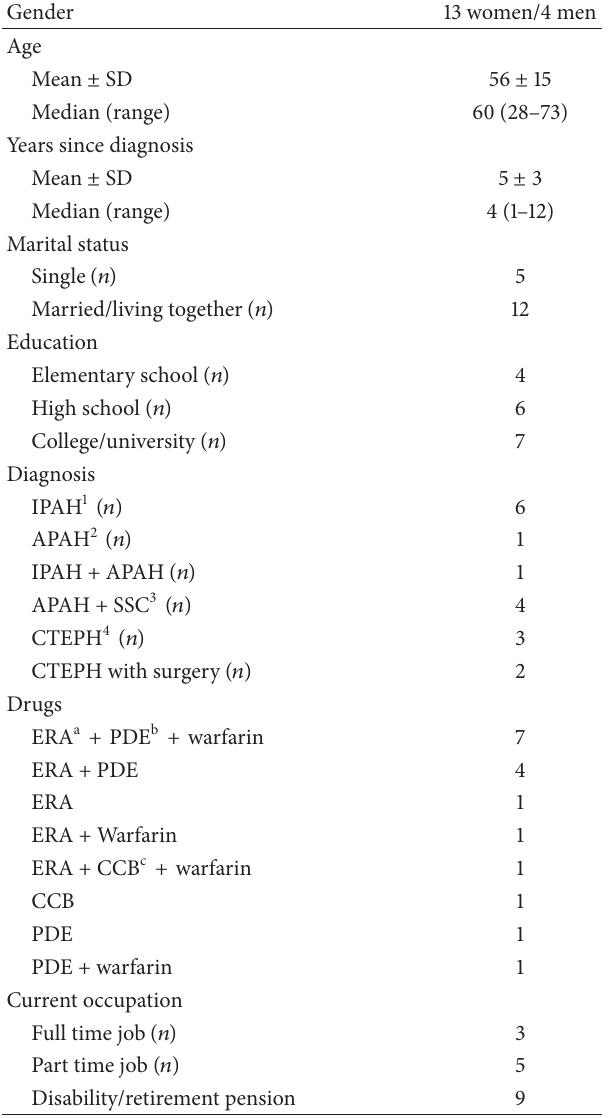
Table 1: Demographic data and disease characteristics of the patients (𝑁 = 17)